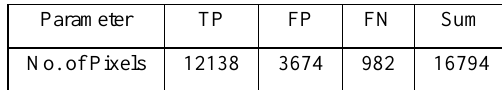
Figure 3. Road mask, superimposed to one GeoEye image The third mask is generated by supervised maximum likelihood classification (MLC) using he pan-sharpened image and the DSM as additional channel. Two classes, namely vegetation and non-vegetation, are defined via carefully selected training sites. Based on manually extracted reference data an overall accuracy of about 75% was reached, see also Figure 4 and Table 1. In Table 1 TP (True Positive) refers to the number of vegetation pixels classified correctly, FP (False Positive) is the number of pixels incorrectly detected as vegetation; FN indicates the number of missed vegetation pixels. Although training sites were carefully chosen, a lack of further radiometric information causes a significant value for FP.